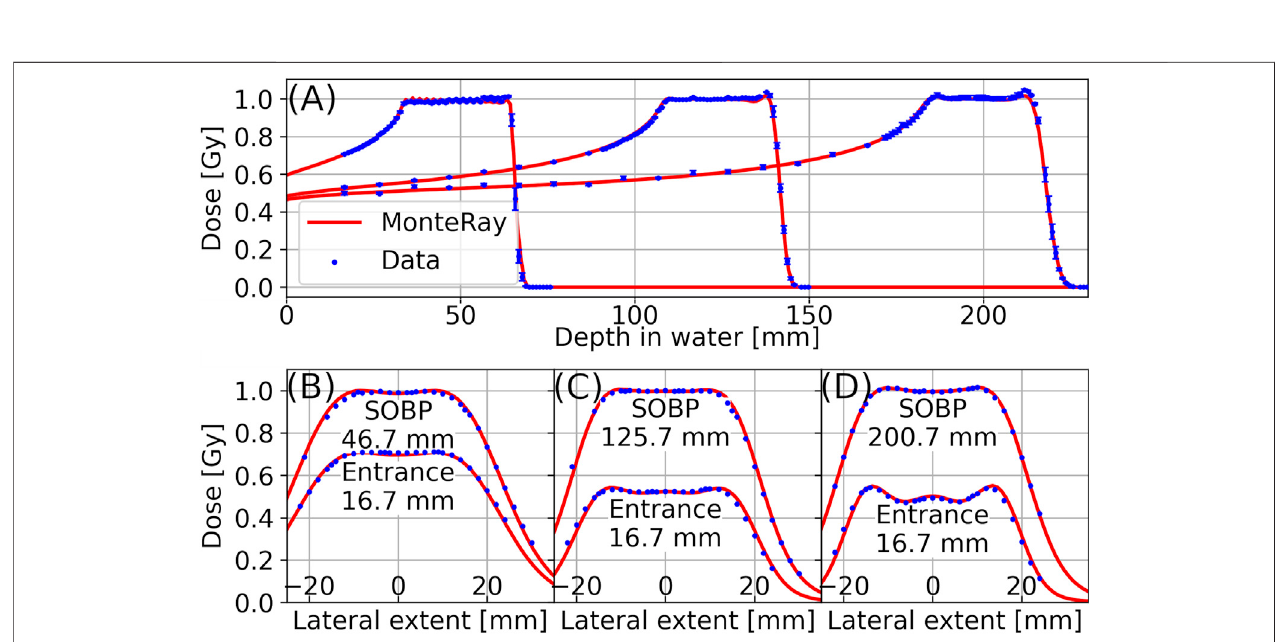
FIGURE 4 | In panel (A) , Longitudinal dose distributions of three proton SOBP plans in water with plateau depths of approximately 5 cm, 12.5, and 20 cm are shown.Inpanels (B) , (C) ,and (D) ,lateralpro fi lescorrespondingtothethreeSOBPplansaredisplayed.ForeachSOBP,onelateralpro fi leattheentranceandonelateral pro fi le in the middle of the SOBP is shown. Measurements (points) are compared against MonteRay ’ s simulated values (lines).